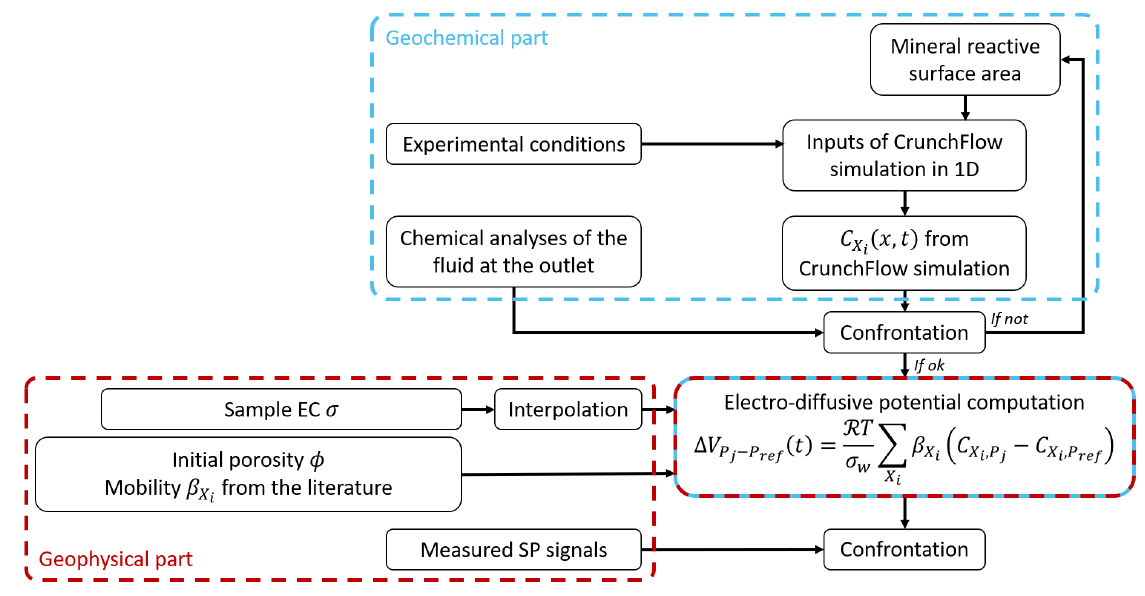
Figure 1. Numerical workflow that couples geochemical simulation (blue dashed framework) with geophysical monitoring (red dashed framework) for the computation of the electro-diffusive